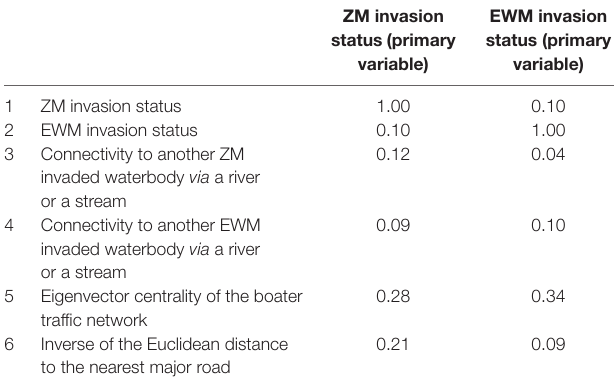
TaBle 2 | Pearson correlation coefficient for the six waterbody-specific variables used in the study.